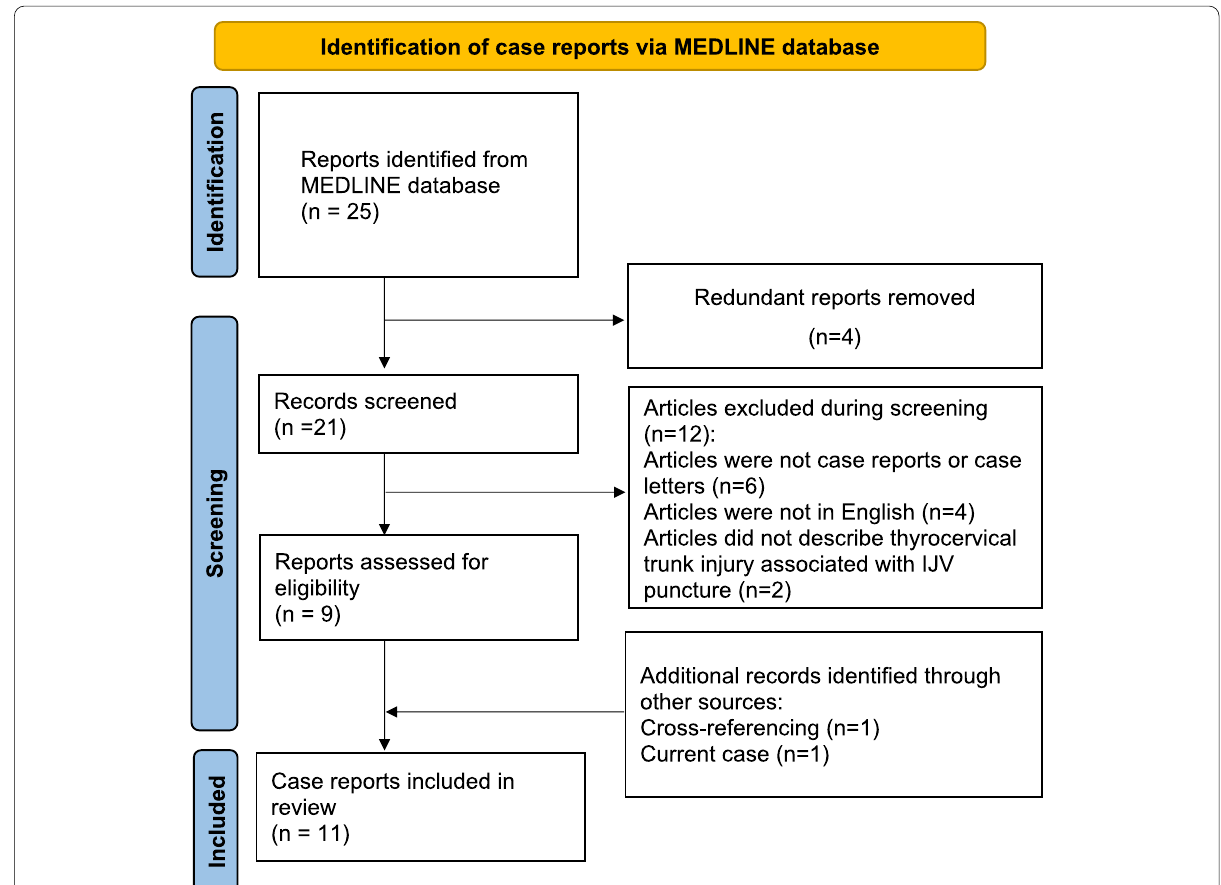
Fig. 2 Flow diagram of the literature review. IJV, internal jugular